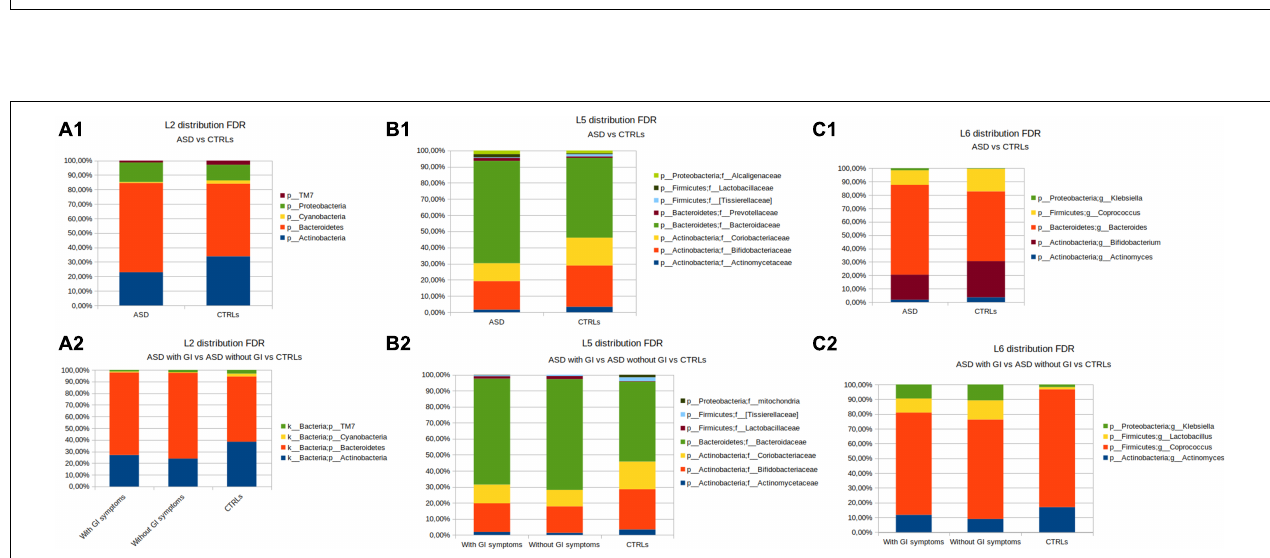
FIGURE 3 | Beta-diversity ecological analysis. Principal Coordinate Analysis (PCoA) plots shows Bray Curtis in (A) . (A1) Patients with ASD versus CTRLs; (A2) , patients with ASD grouped for presence of GI (with GI) or GI absence (without GI) symptoms versus CTRLs cohorts. Weighted UniFrac algorithms in (B) . (B1) Patients with ASD versus CTRLs; (B2) , patients with ASD grouped for presence of GI (with GI) or GI absence (without GI) symptoms versus CTRLs cohorts. Unweighted UniFrac algorithms in (C) . (C1) Patients with ASD versus CTRLs; (C2) , patients with ASD grouped for presence of GI (with GI) or GI absence (without GI) symptoms versus CTRLs cohorts.